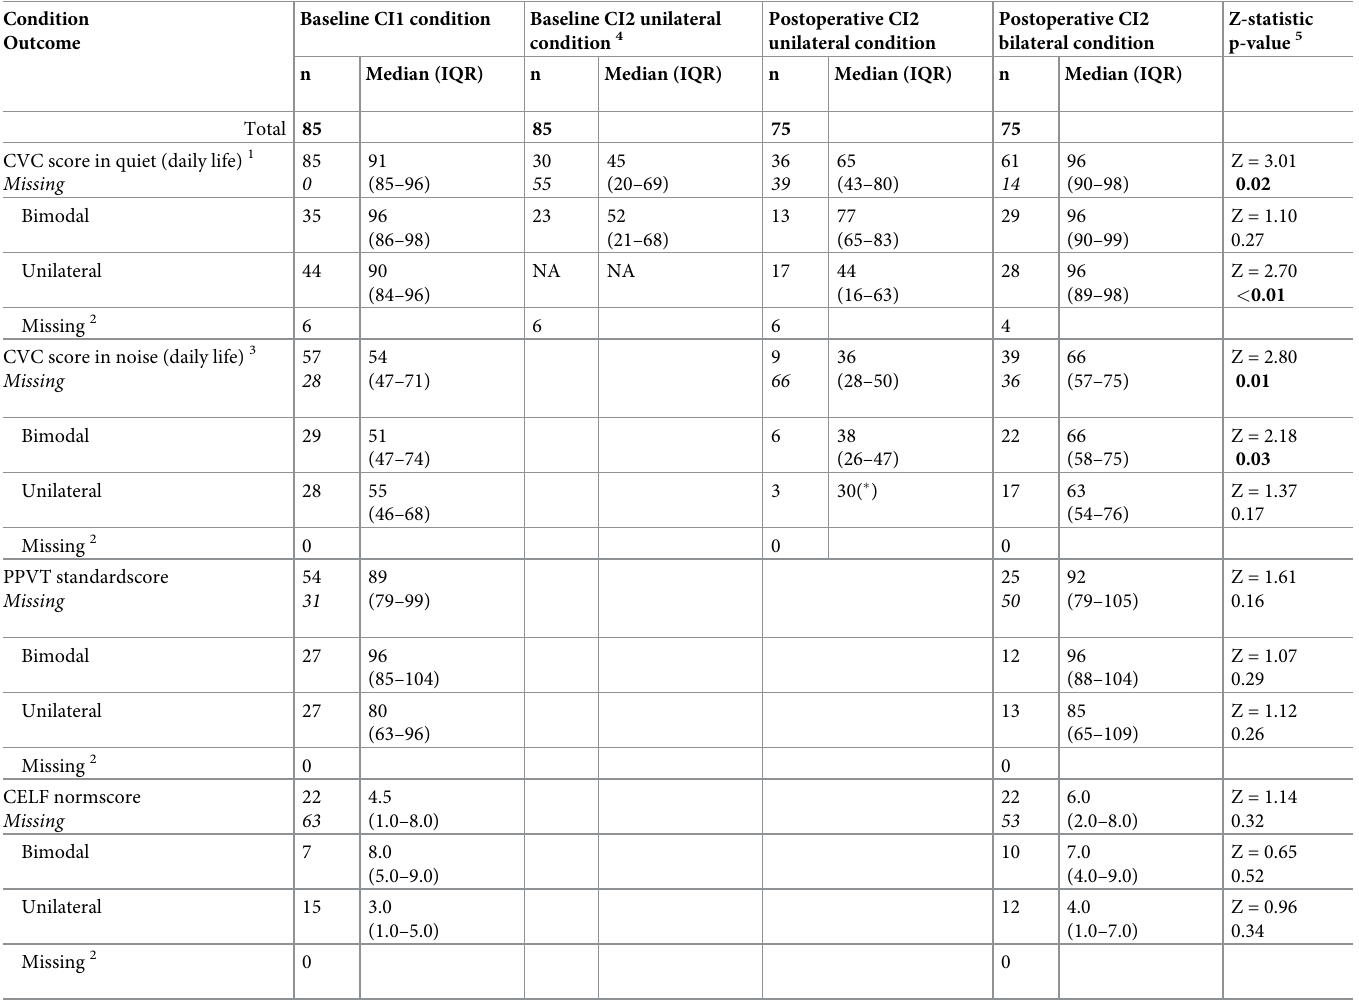
Table 2. Results of speech recognition and speech and language development